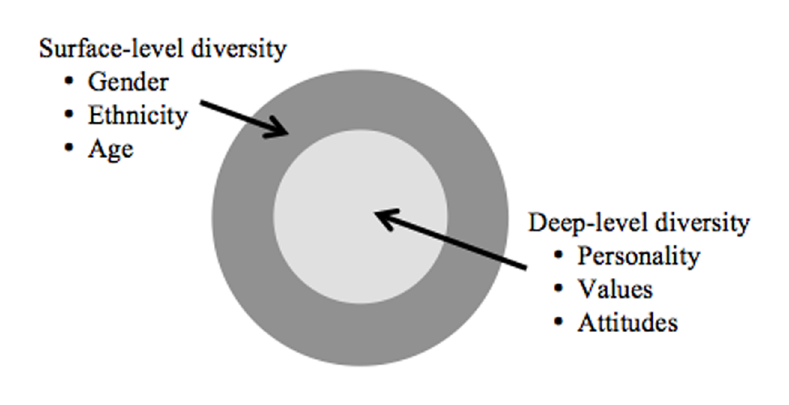
Figure 1. Surface-level versus deep-level